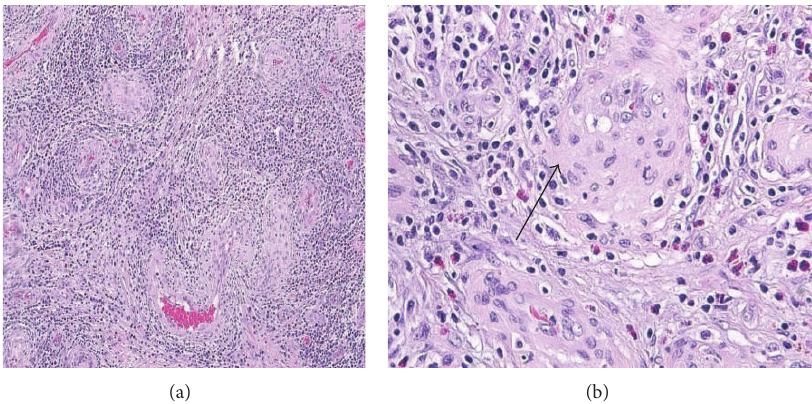
Figure 4: Histological images of the second biopsy: (a) HE: lower magnification, compared to the first biopsy blood vessels are surrounded by a denser inflammatory infiltrate. (b) HE: higher magnification, showing marked endothelial proliferation. Endothelial cells are plump (arrow). Many eosinophils are